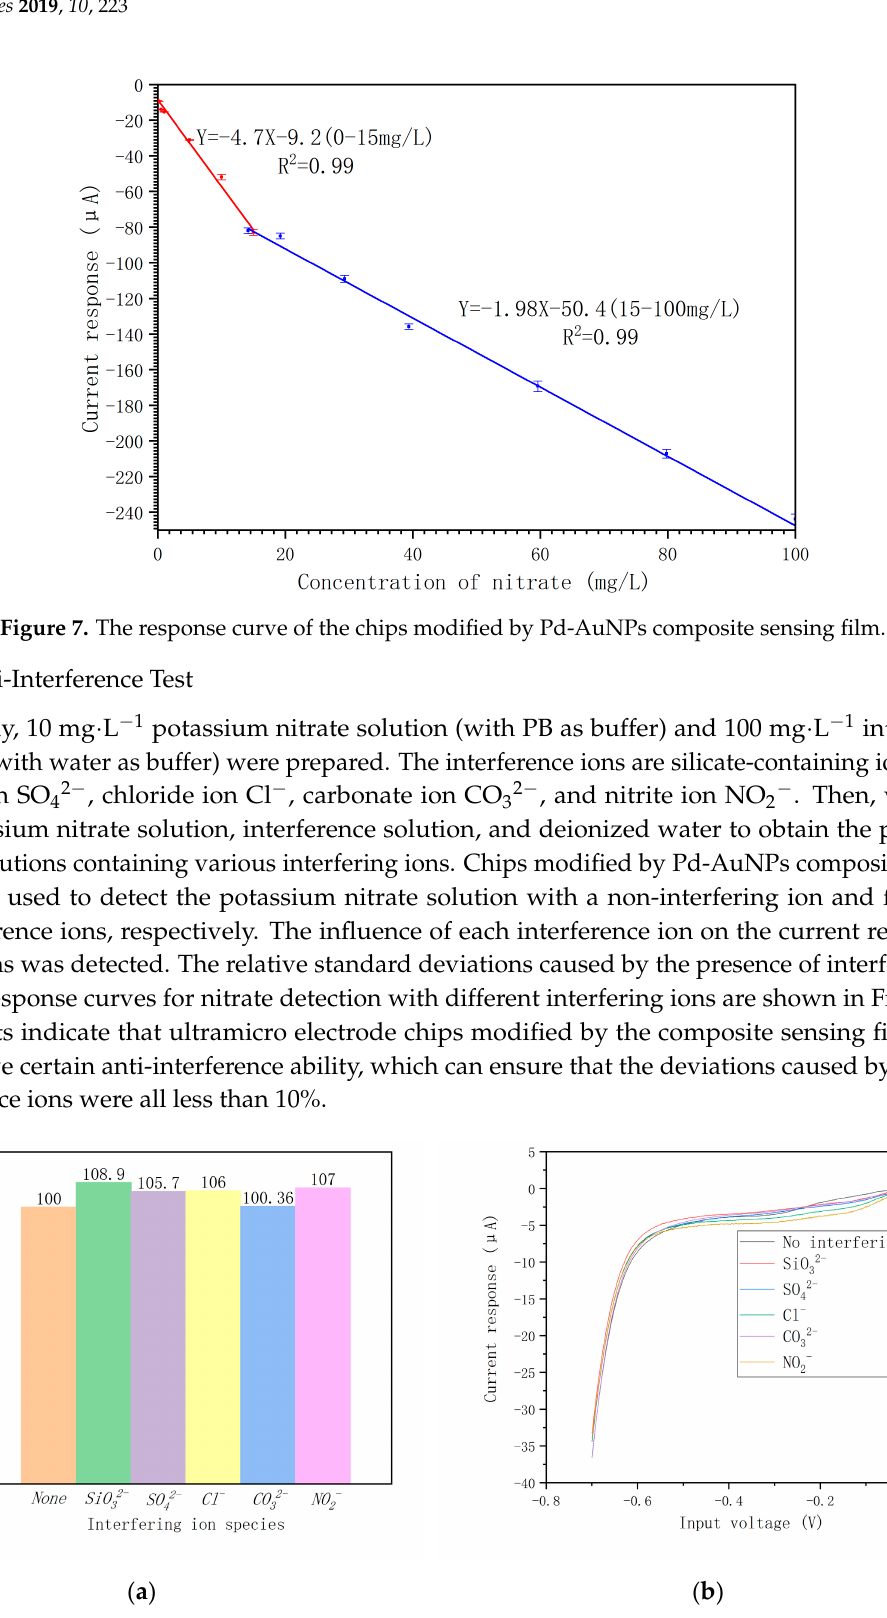
Figure 8. ( a ) Relative standard deviations caused by different interference ions. ( b ) The response curves for nitrate detection with different interfering ions.